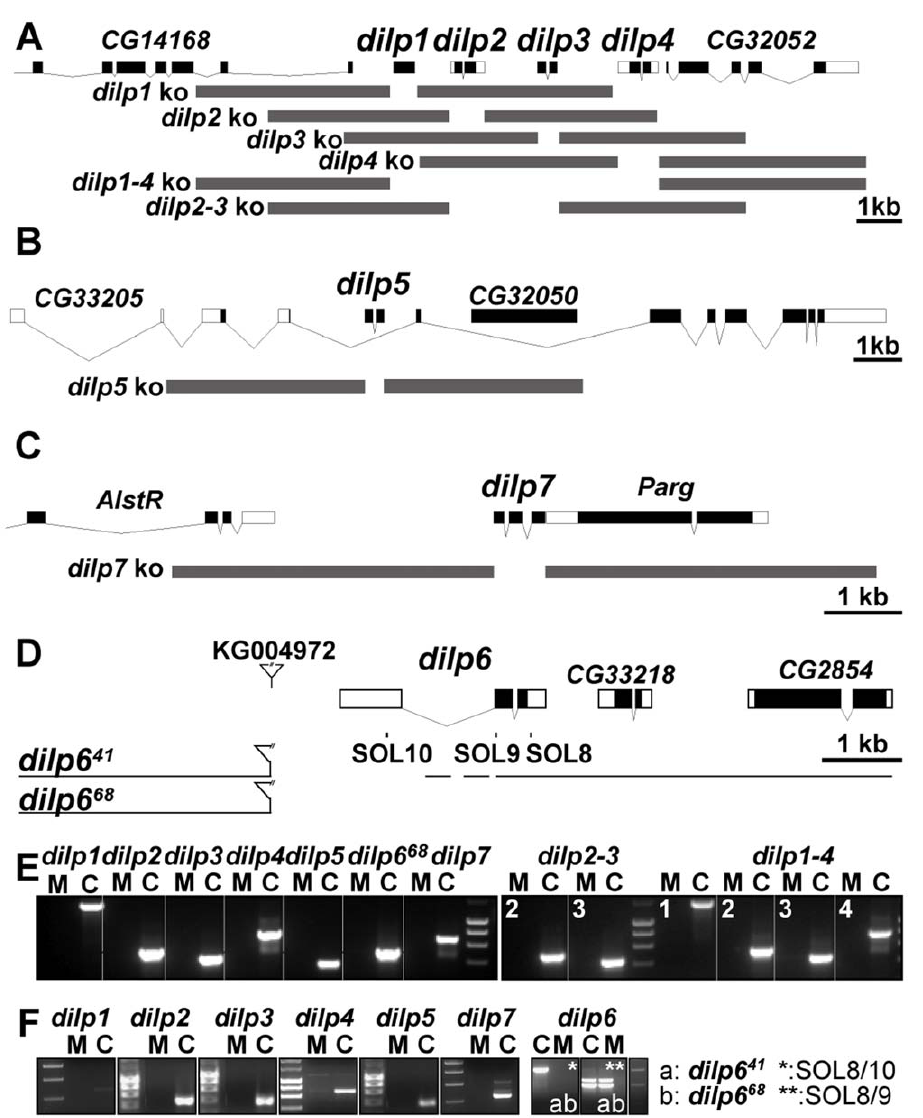
Figure 2. Gene locus organization and generation of dilp mutants. (A–C) Null mutations for dilp1, 2, 3, 4, 5, 7, 2 – 3 , and 1 – 4 were generated by ends-out homologous recombination and by imprecise P-element excision for dilp6 (D). (A) The dilp1 – 4 genes cluster at cytological position 67C8 is separated from dilp5 by two intervening genes of unknown function (Flybase: CG32052 and CG33205 ). (B) dilp5 is located within an intron of the CG33205 gene. (C) dilp7 is located on the X-chromosome at 3E2 immediately downstream of the essential Poly(ADP-ribose) glycohydrolase ( Parg ) gene. Donor constructs (dilp ko) for ends-out homologous recombination are indicated by grey bars. Gap between grey bars indicates the genomic region replaced by a white hs marker gene. Coding parts of exons are marked in black, non-coding parts by white boxes. (D) Transposon integration line KG004972 was used to generate dilp6 deletion mutants dilp6 41 and dilp6 68 . Note: both dilp6 deletion alleles contain remaining P-element sequence, hatched line: region of breakpoint in dilp6 41 . (E) PCR on genomic DNA of dilp mutants with dilp specific primer combinations shows homologous recombination mediated replacement of dilp genes by the white hs marker gene and deletion of dilp6 in dilp6 68 mutants (M: mutant, C: control). (F) RT– PCR analysis confirms that dilp mutants are transcript null alleles. dilp6 41 mutants express ectopic dilp6 transcripts that lack the first exon but contain the full ORF. dilp6 68 mutants are dilp6 transcript null alleles.